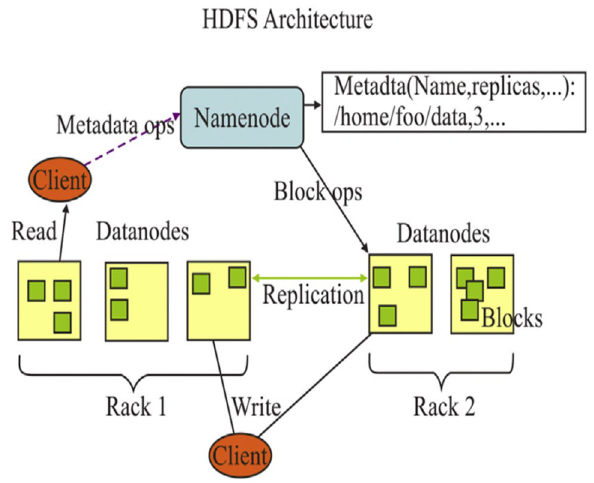
Fig. 1 HDFS architecture with name node and data nodes (Borthakur